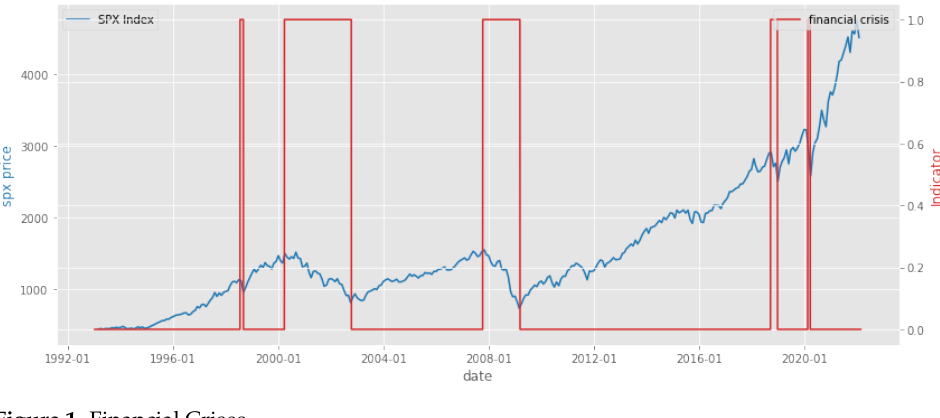
Figure 1. Financial